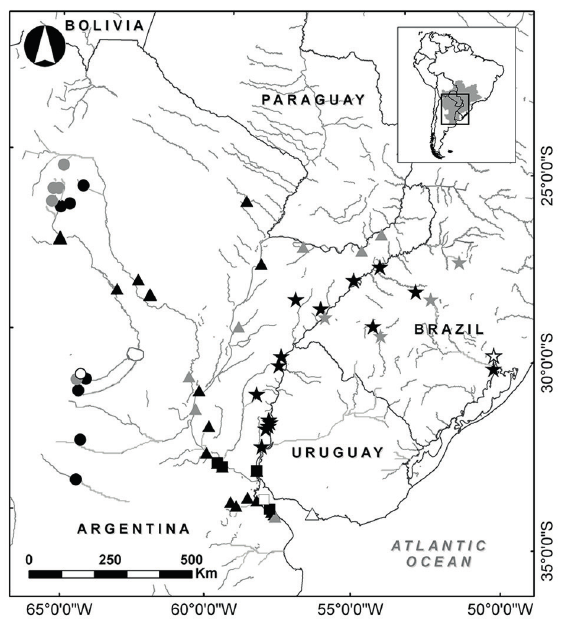
Figure 1 - Map of collection localities of Hypostomus commersoni (triangle), H. spiniger (star) , H. cordovae (circles) and H. laplatae (squares). White symbols are type localities and grey symbols are specimens used only in molecular